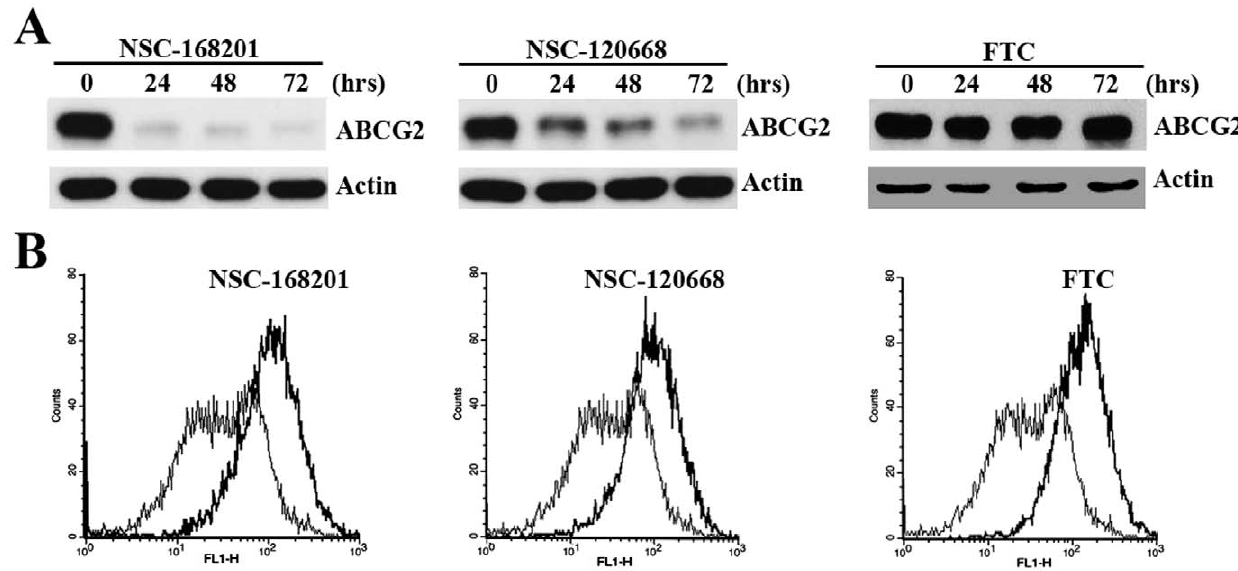
Figure 3. Effect of NSC compounds on ABCG2 expression and mitoxantrone efflux. A, ABCG2 expression. HEK293/ABCG2 cells were treated with 10 m M each of the known ABCG2 inhibitors NSC-168201, NSC-120668, or FTC for various times followed by Western blot analysis of ABCG2 expression probed with monoclonal antibody BXP-21. B, mitoxantrone accumulation. HEK293/ABCG2 cells were incubated with mitoxantrone for 30 min in the presence of DMSO (thin line) or 10 m M NSC-168201, NSC-120668, or FTC (thick line) followed by FACS analysis of intracellular mitoxantrone level.